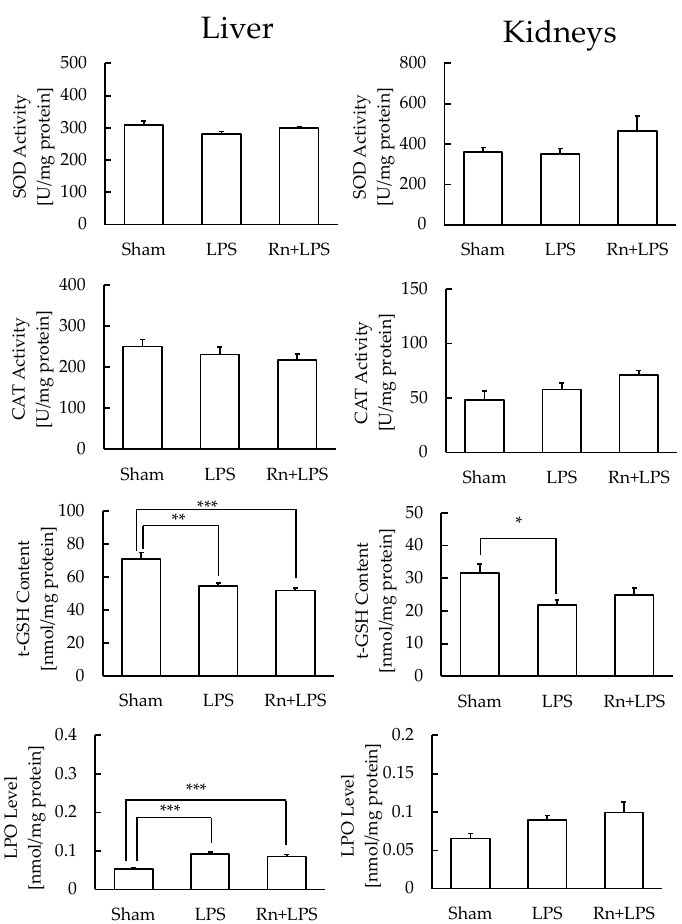
Figure 3. Effect of radon (Rn) inhalation on oxidative stress associated with LPS administration in the liver and kidneys. The results are presented as the mean ± SEM. N = 7; * p < 0.05, ** p < 0.01, *** p < 0.001; all experiments were conducted once; * p < 0.05, ** p < 0.01, *** p < 0.001; sham, mouse group without any treatment; sham + LPS, mouse group that inhaled sham followed by LPS (1 mg/kg body weight); Rn + LPS, mouse group that inhaled radon (2000 Bq/m 3 ) followed by LPS (1 mg/kg body weight); SOD, superoxide dismutase; CAT, catalase; GSH, glutathione; LPO, lipid peroxide.